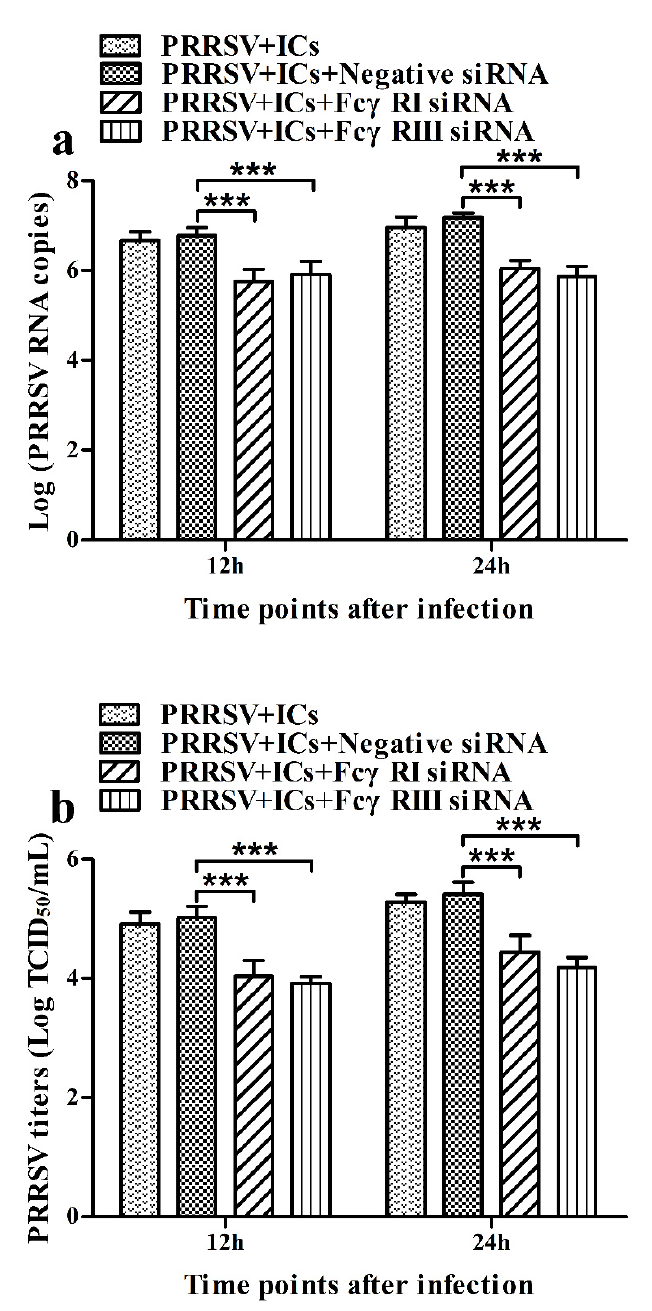
Figure 8. Effect of Fc γ RI gene knockdown or Fc γ RIII gene knockdown on PRRSV replication by the ADE infection in porcine AMs. The cells were transfected with Fc γ RI siRNA, Fc γ RIII siRNA or negative siRNA for 48h and then infected with PRRSV+ICs. ( a ) Real-time RT-PCR analysis of PRRSV RNA copies in culture supernatants of PRRSV+ICs-infected cells transfected with Fc γ RI siRNA, Fc γ RIII siRNA or negative siRNA. ( b ) PRRSV titers in culture supernatants of PRRSV+ICs-infected cells transfected with Fc γ RI siRNA, Fc γ RIII siRNA or negative siRNA from three independent experiments were measured in Marc-145 cells and expressed as TCID 50 /mL. *** p < 0.001. Note: siRNA: small interfering RNA; Fc γ RI: Fc gamma receptor I; Fc γ RIII: Fc gamma receptor III; ADE: antibody-dependent enhancement; PRRSV+ICs: PRRSV+porcine IgG against PRRSV.